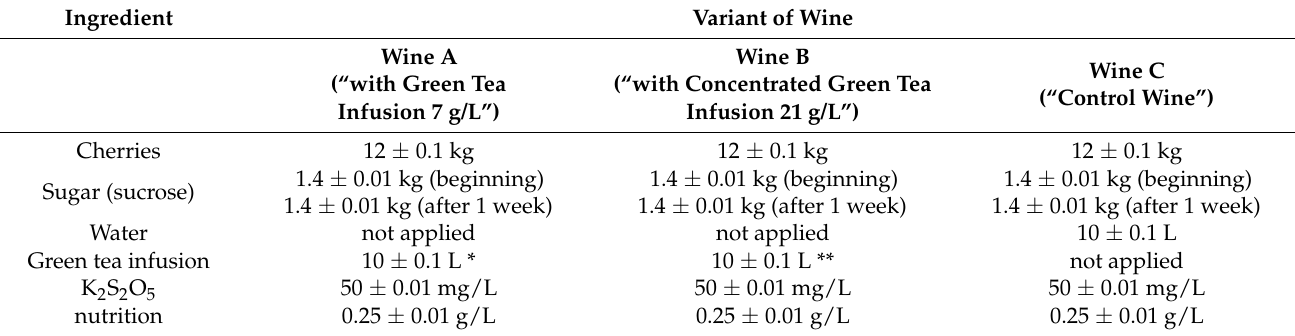
Table 1. Composition of cherry